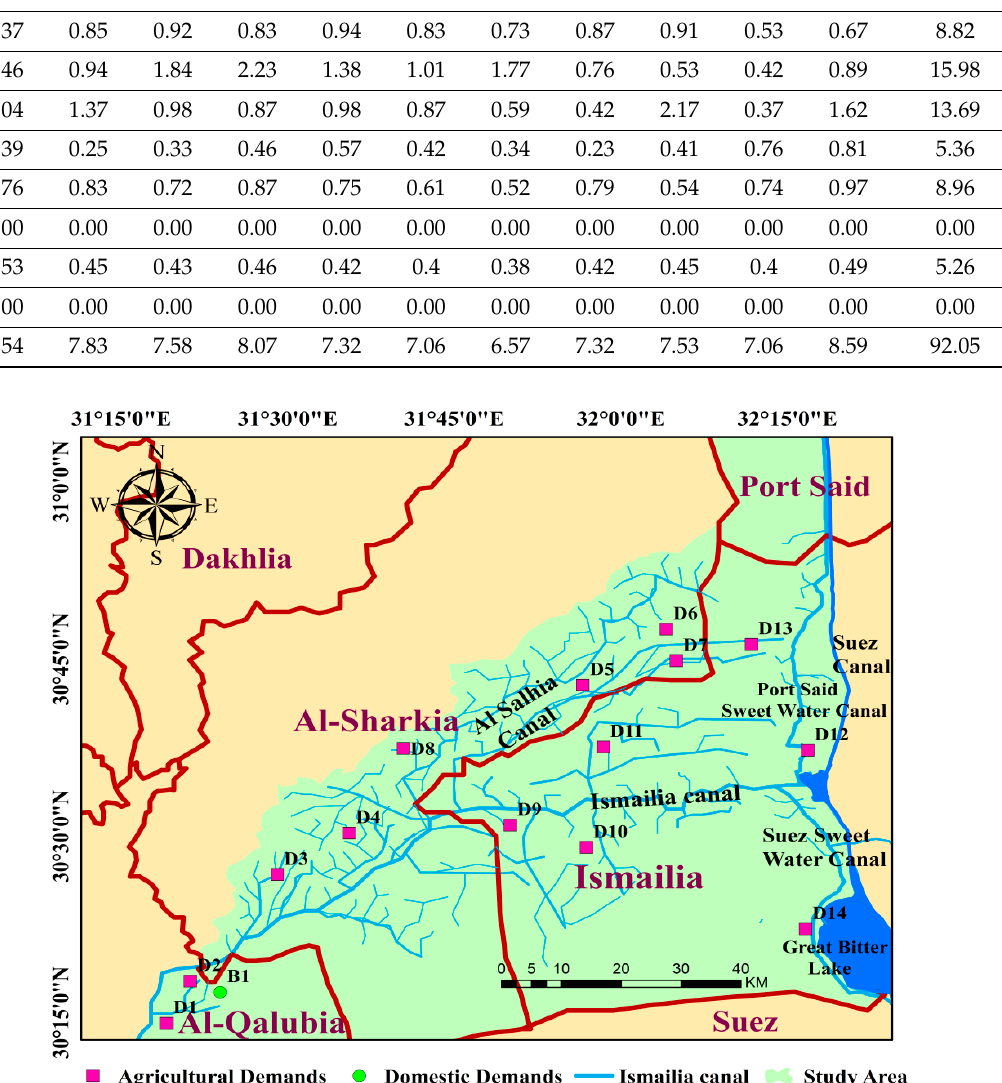
Figure 10. Location of DEMs and Boosters which groundwater pumped to them. Drainage water reuse is considered to be the most unconventional water resource in study regions of Ismailia and Al-Sharkia. The reuse of agricultural drainage water is the second most used water resource of the Ismailia and Sharkia governorates, with 93 water mixing stations available in the Sharkia governorate with 1.4 BCM, and serving approxi- mately 140,700 feddan [33]. The length of the covered drains in the Ismailia governorate reached 120 km in 2017, and was comprised of 21 drains serving of approximately 47,000 feddans. On the other hand, the open-drain lengths in the Ismailia governorate reached 204 km in 2017 with served of about 58,000 feddan [34]. Running the model showed that, in the study area, the amount of reused drainage water that arrived at the agricultural area was approximately 1095.37 Mm 3 /year, as shown in Table 10. The center which benefited the most from the reused drainage water was Al Salhiya, which is situated at the end of the Al Salhiya Canal (a branch of the Ismailia Ca- nal), as shown in Figure 11. Table 10. Monthly reuse water distribution in the study area (MCM). DEM & Booster